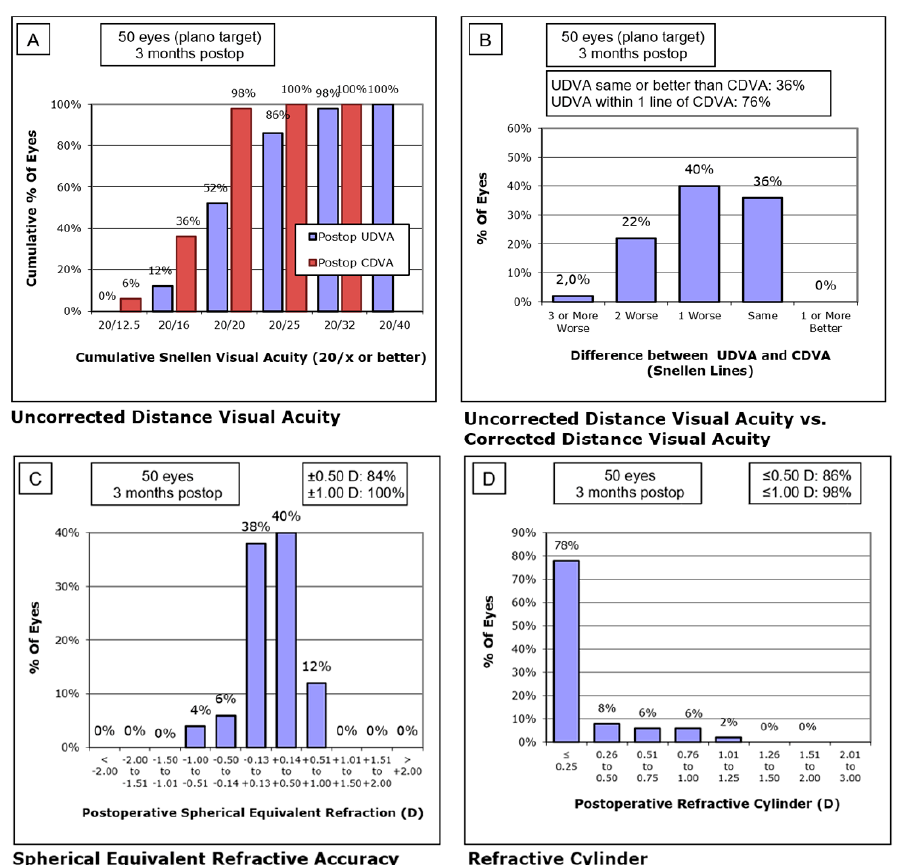
Figure 2. Refractive and visual postoperative outcomes. ( A ) Cumulative Snellen uncorrected dis- tance visual acuity; ( B ) Difference between uncorrected distance visual acuity versus corrected distance visual acuity; ( C ) Postoperative spherical equivalent refraction; ( D ) Postoperative residual refractive cylinder.